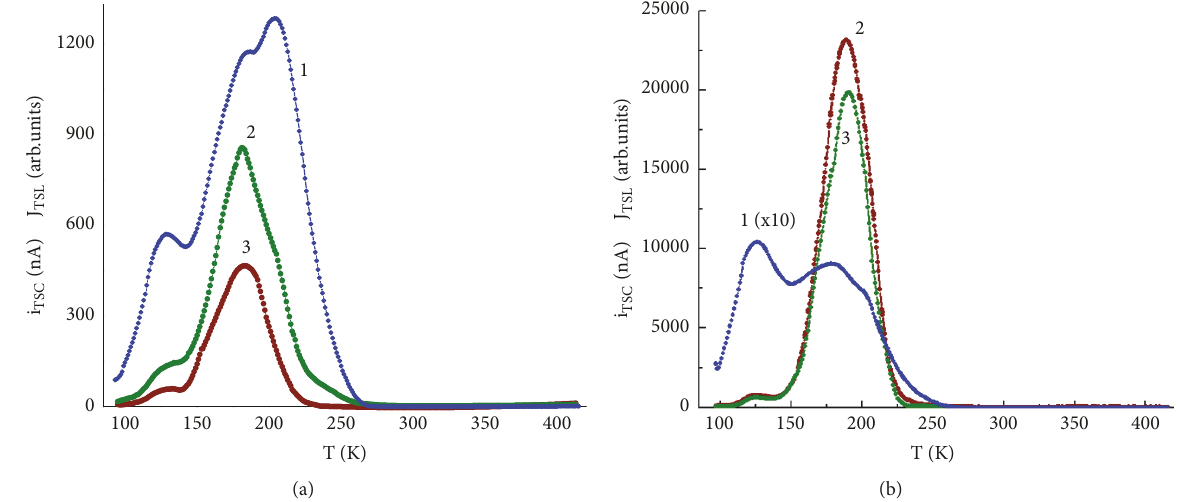
Figure 3: TSC (1) , TSL-630 (2) , and TSL-970 (3) curves of ZnSe sample #1: at a low dose of radiation ( 𝐷 X = 7.8 mJ/cm 2 ) (a) and at a high dose of radiation ( 𝐷 X = 4608 mJ/cm 2 ) (b).